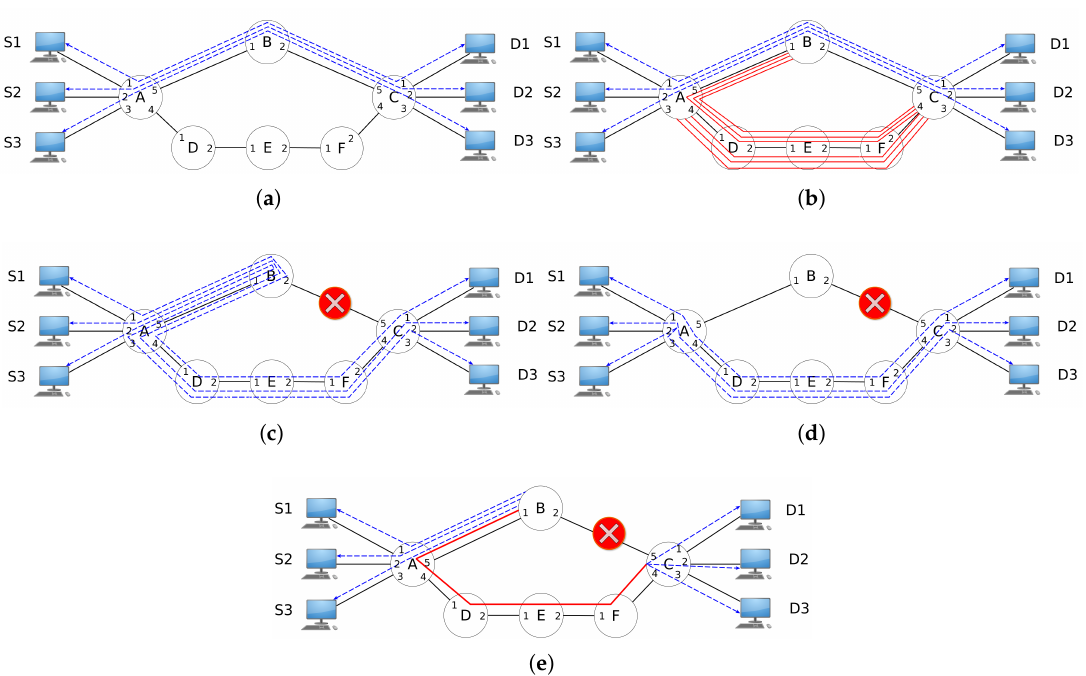
Figure 3. Examples of resilience mechanisms for OpenFlow networks. ( a ) Flows created from and to nodes; ( b ) additional rules of Path Protection (PP); ( c ) after link B-C failure and application of Local Restoration (LR); ( d ) after link B-C failure and application of Path Restoration (PR); ( e ) after link B-C failure and application of Local Fast Restoration